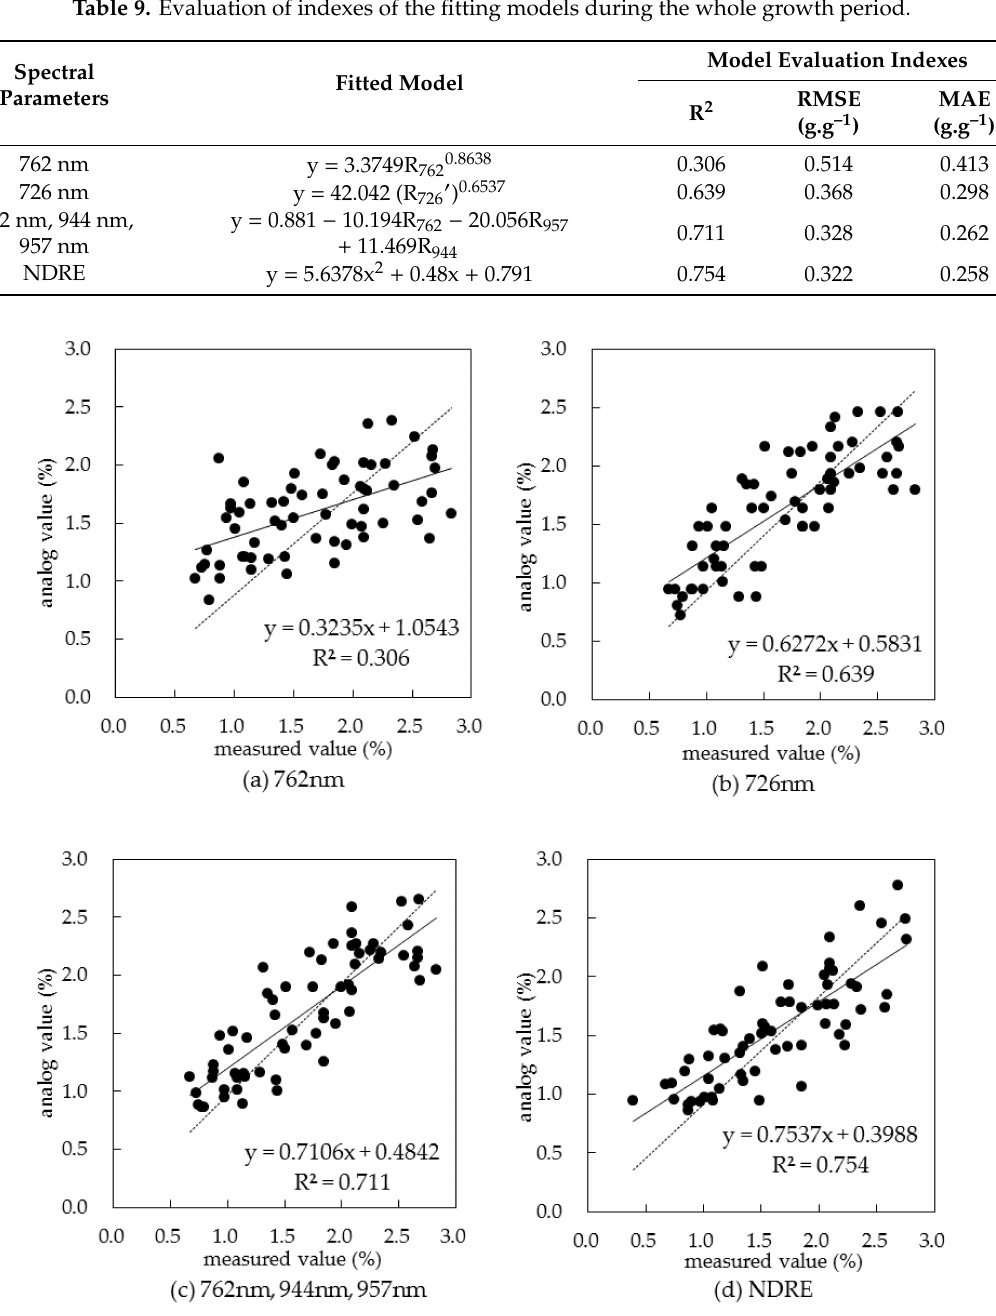
Figure 7. Comparisons between analog and measured values for the fitting